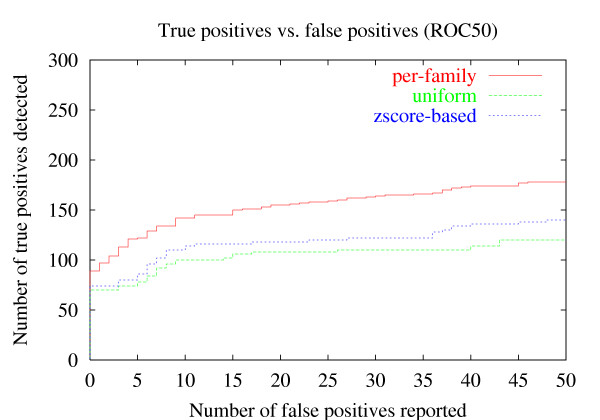
Comparison of different methods for assessing pvalue. For each method we plot the ROC50 curve (see section for details). Note that the zscore-based approach is better than the uniform approach, and is outperformed by the per-family approach.